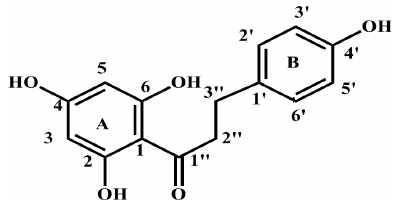
Figure 1. Chemical structure of phloretin.